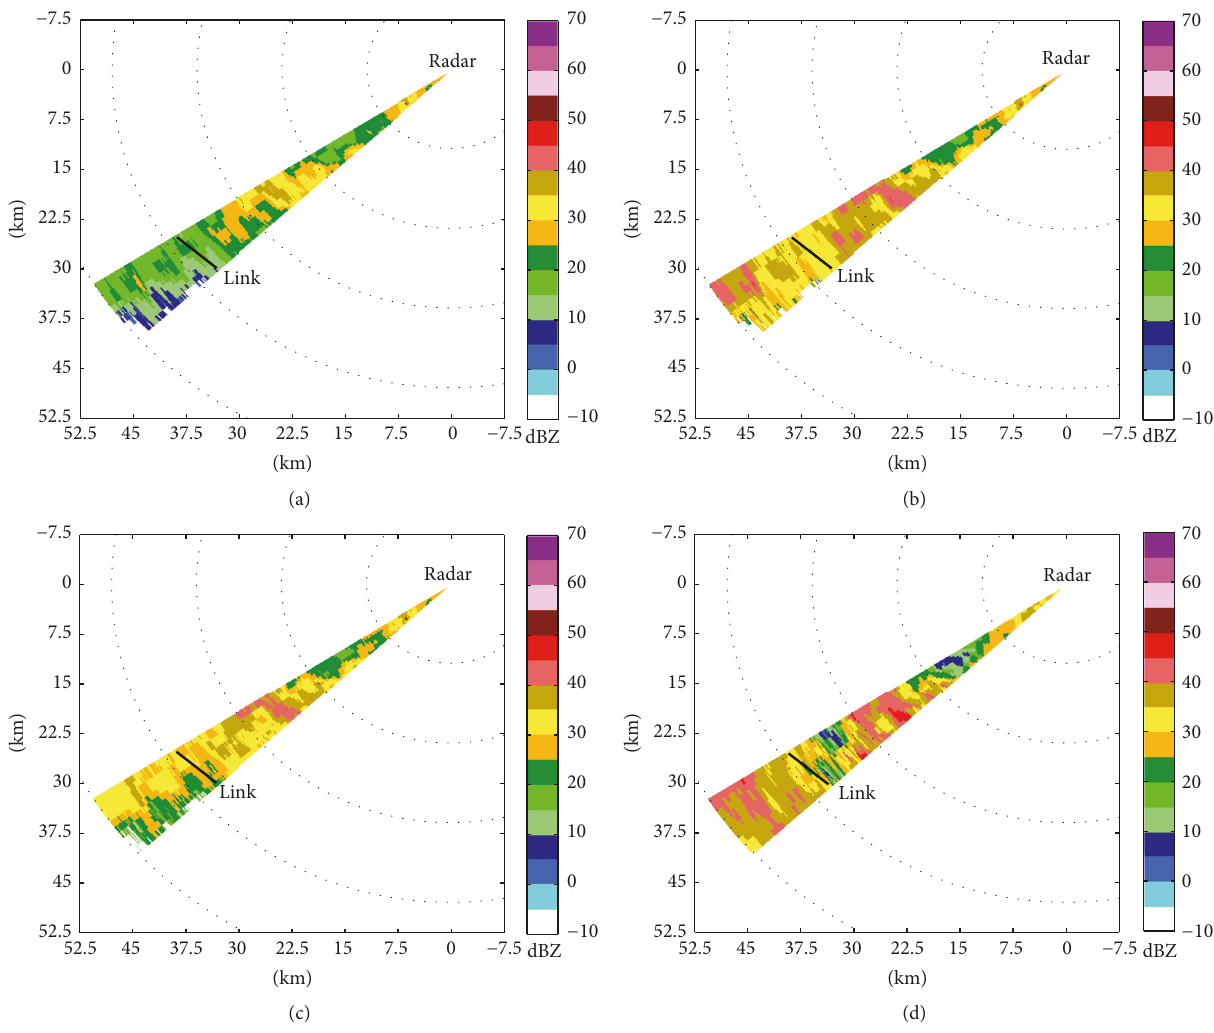
Figure 9: Reflectivity of (a) the XR before attenuation correction, (b) the XR after ACML attenuation correction, (c) the XR after SC attenuation correction at 0731 UTC, and (d) the SR at 0730 UTC, 2 June 2015. The microwave link is shown as black straight line in all figures.